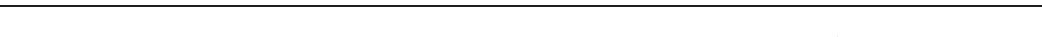
Fig. 1 Self-restraint role of P38 in stress erythropoiesis. a Phosphorylation of P38 in starved human CD34 + HSPCs-derived erythroblasts stimulated with EPO (2 U ml − 1 ) at indicated time points. b , c Apoptosis in human CD34 + HSPCs-derived erythroblasts induced by BSO (200 nM) ( n = 4) ( b ) or Jak2 inhibitor II (40 µ M) ( n = 3) ( c ) with DMSO or SB203580 (10 µ M) quanti fi ed by fl ow cytometry using Annexin V and DAPI staining. d PHZ-induced